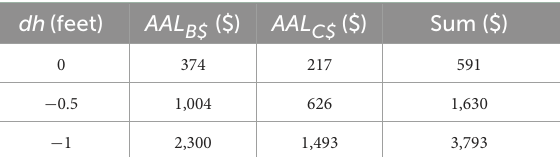
TABLE 5 Sensitivity of mean of the average annual loss values to building and contents (USD) per home to depth-damage function damage initiation